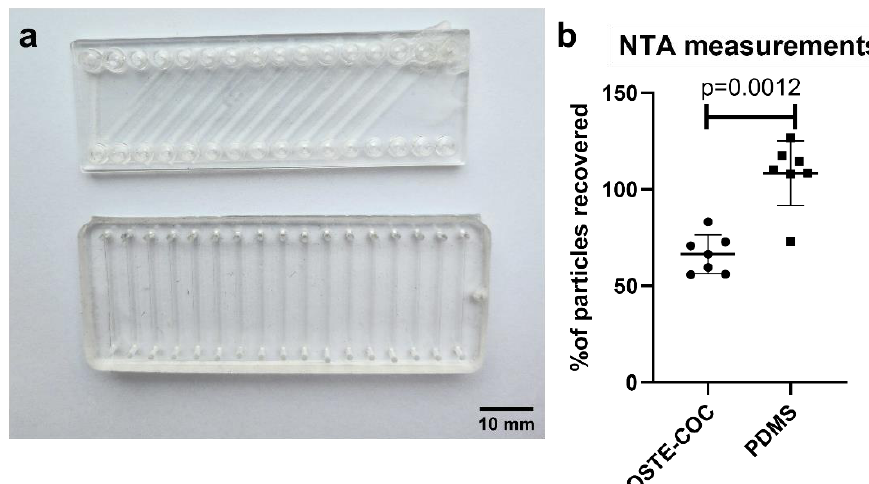
Figure 7. Single channel experiments for EV-loss quantification. ( a ) Top-OSTE—COC single-channel devices. Bottom-PDMS single channel devices. Both devices have the same microfluidic channel dimensions, but the COC device has a slanted channel layout to accommodate this length on a microscope slide format, ( b ) Scatter dot plot of EV recovery percentage from OSTE-COC and PDMS single channel devices with mean and SD.